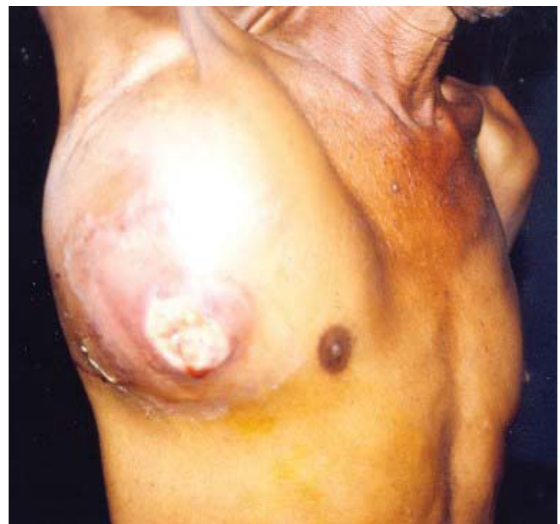
Figure 1. Ulcerated lump involving right breast and axilla